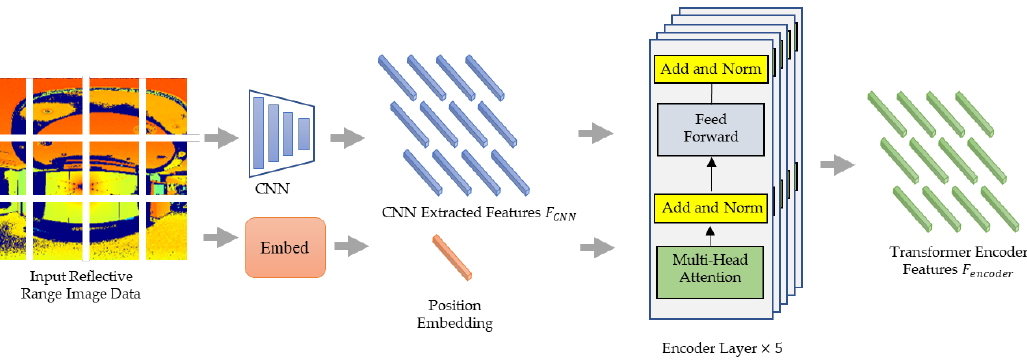
Figure 6. Transformer encoder view.